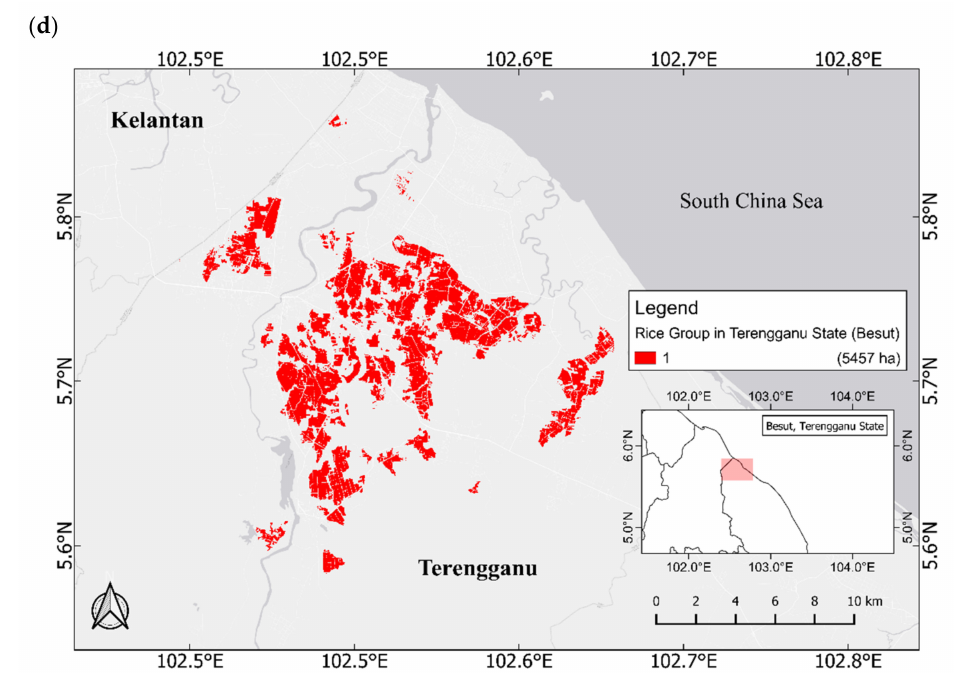
Figure 6. Map of rice field cropping patterns in ( a ) Selangor State, ( b ) Kedah and Perlis States, ( c ) Penang State, and ( d ) Besut district, Terengganu state. Figure 6 corresponds to Figure 3a,b and Table